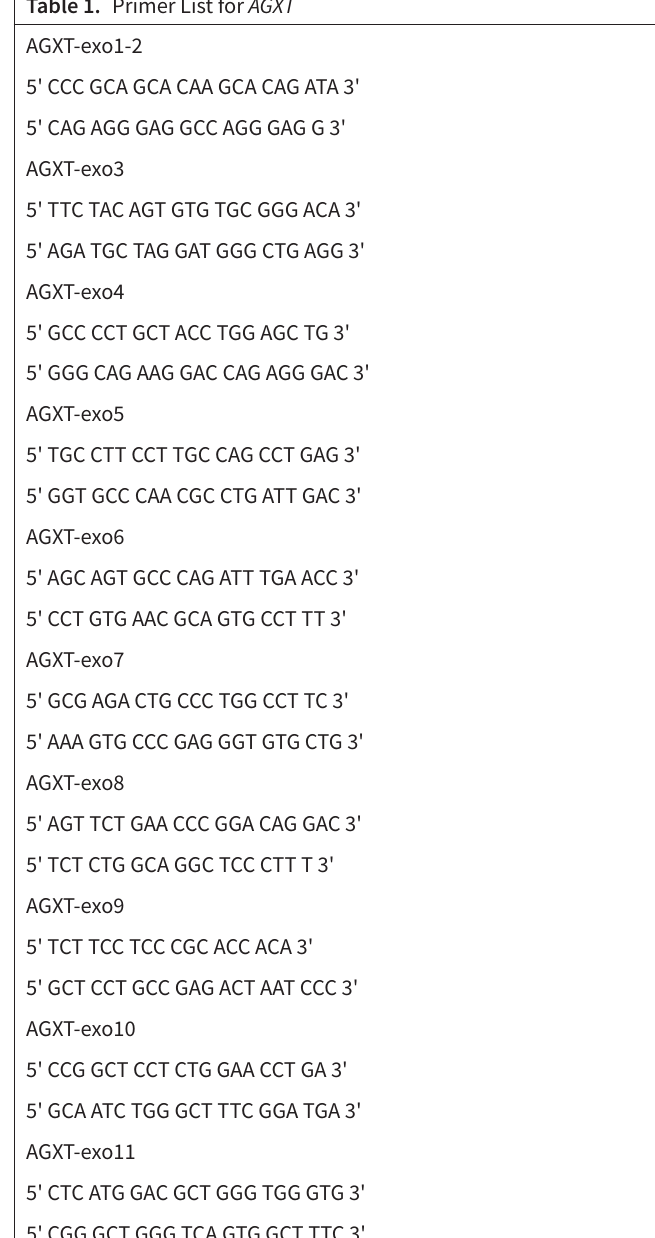
Table 1. Primer List for